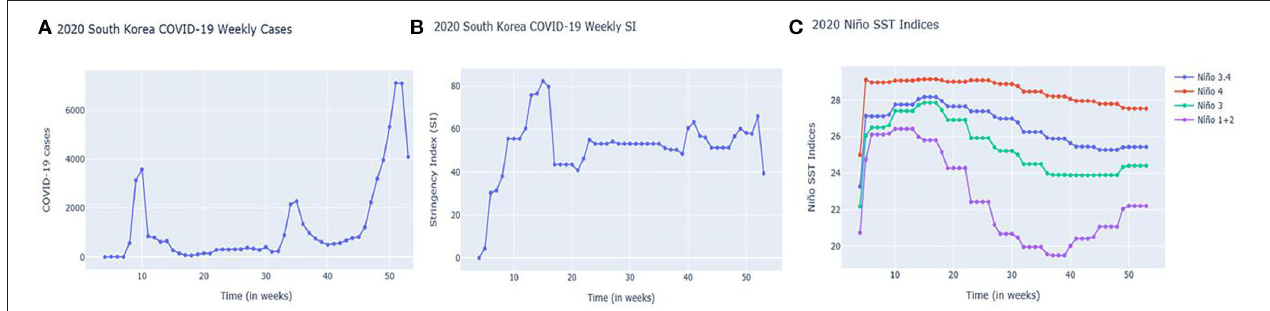
FIGURE 1 | South Korea’s Weekly (A) COVID-19 cases; (B) Stringency Index (SI); and (C) Niño SST indices from January 21, 2020 to December 31, 2020 (4th week to 53rd week).